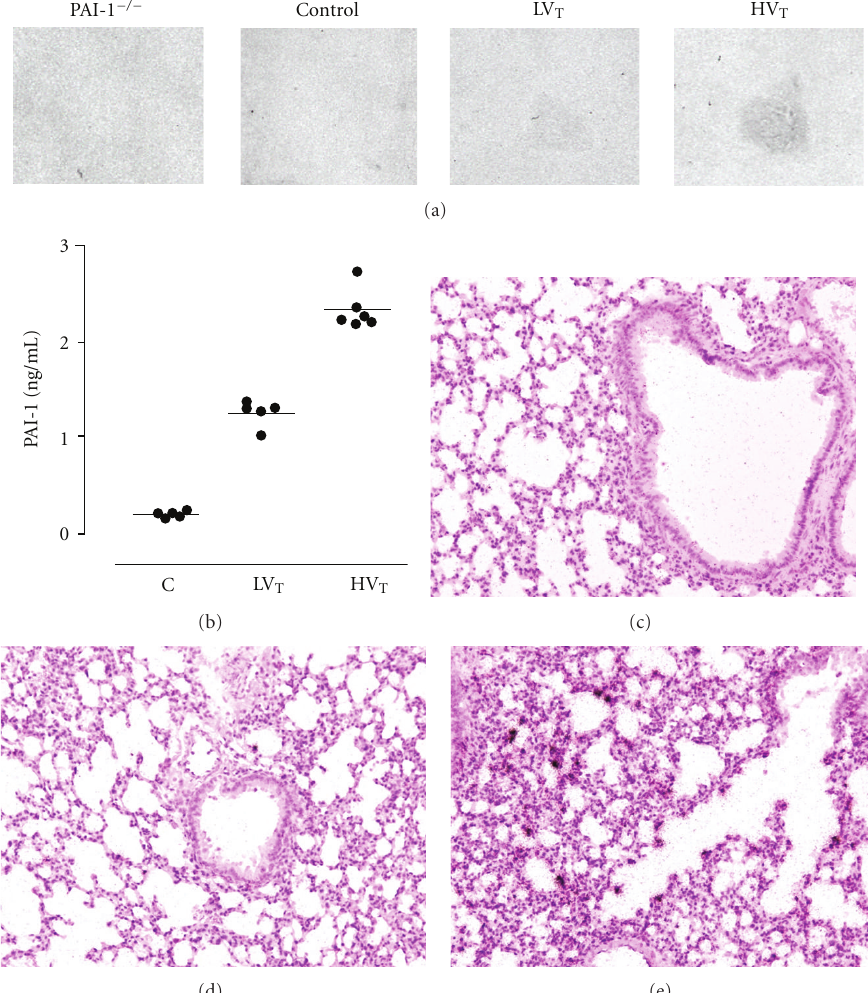
Figure 1: (a) Plasminogen activator inhibitor- (PAI-) 1 mRNA in lung. PAI-1 mRNA as determined by radioactive in situ hybridization (autoradiographic film). (b) PAI-1 levels in bronchoalveolar lavage fluid in anesthetized nonventilated control (c) mice, mice ventilated with low tidal volumes (LV T ) and high V T (HV T ). Levels of PAI-1 in PAI-1 − / − mice were undetectable. Data are represented as individual data with a median. In situ hybridization for murine PAI-1 mRNA was performed on para ffi n slides of nonventilated control Wt mice (c), Wt mice ventilated with LV T (d) and HV T (e) for 5 hours. Positive signal in black. Original magnification